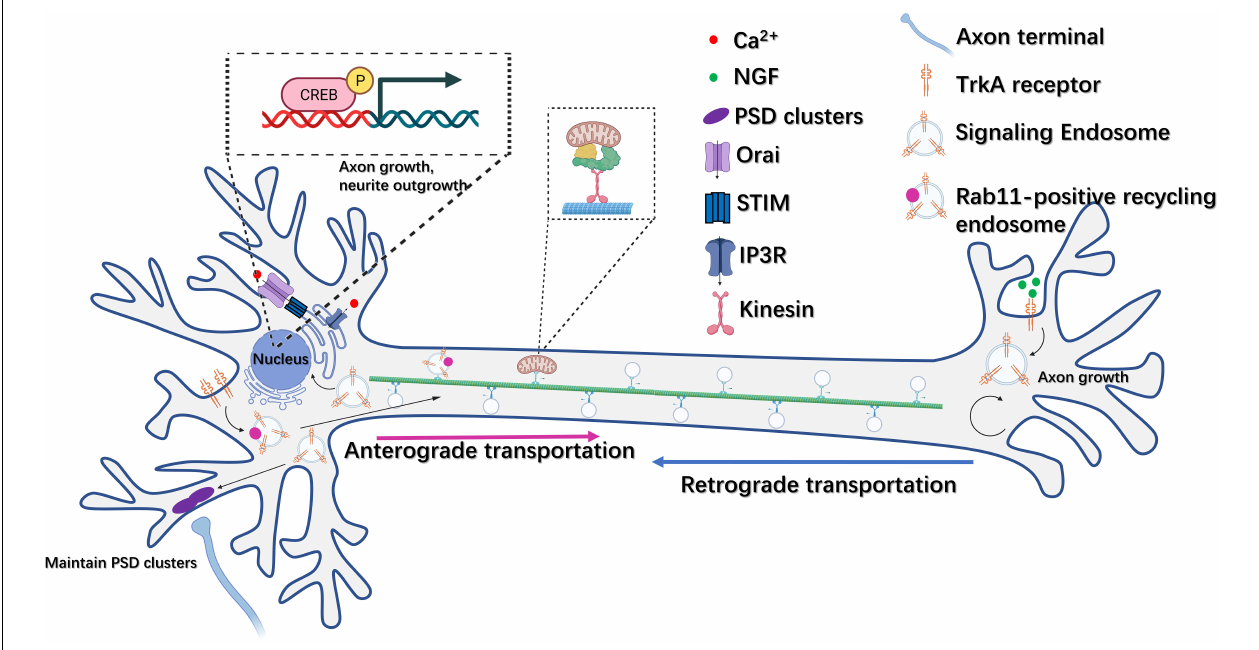
FIGURE 3 | Endosome trafficking is involved in the regulation of neural plasticity. NGF-TrkA recycling endosomes can be retrogradely transported from the axon to the cell body and mediate the activation of genes related to axon outgrowth and neural differentiation, such as CREB. In addition, TrkA receptors can also be transported anterogradely from the plasma membrane at the soma to axon terminals via Rab11-positive recycling endosomes. Moreover, NGF-TrkA signaling endosomes can function at local axon tips to regulate axon growth. NGF-TrkA endosomes can promote synaptic maintenance through the aggregation of postsynaptic density clusters in